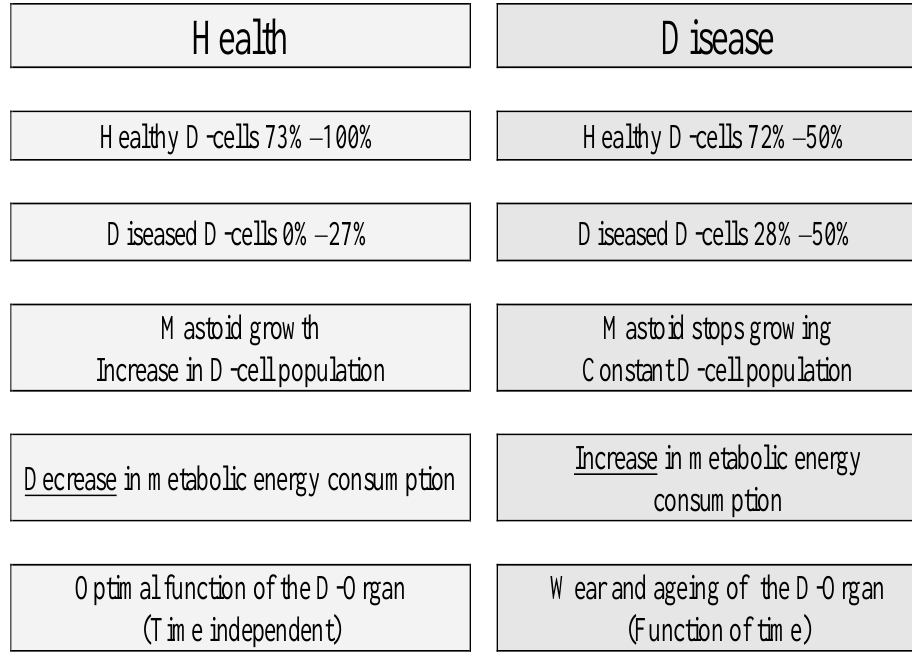
Figure 5. The complementary states of the D-Organ (middle-ear